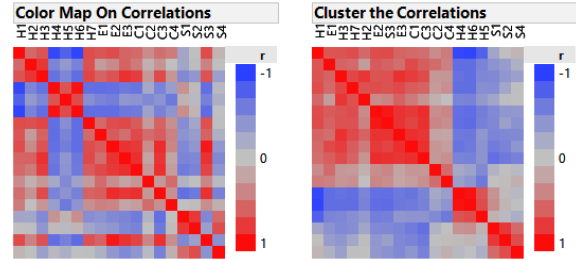
Figure 1. Correlation maps of selected health indicators.